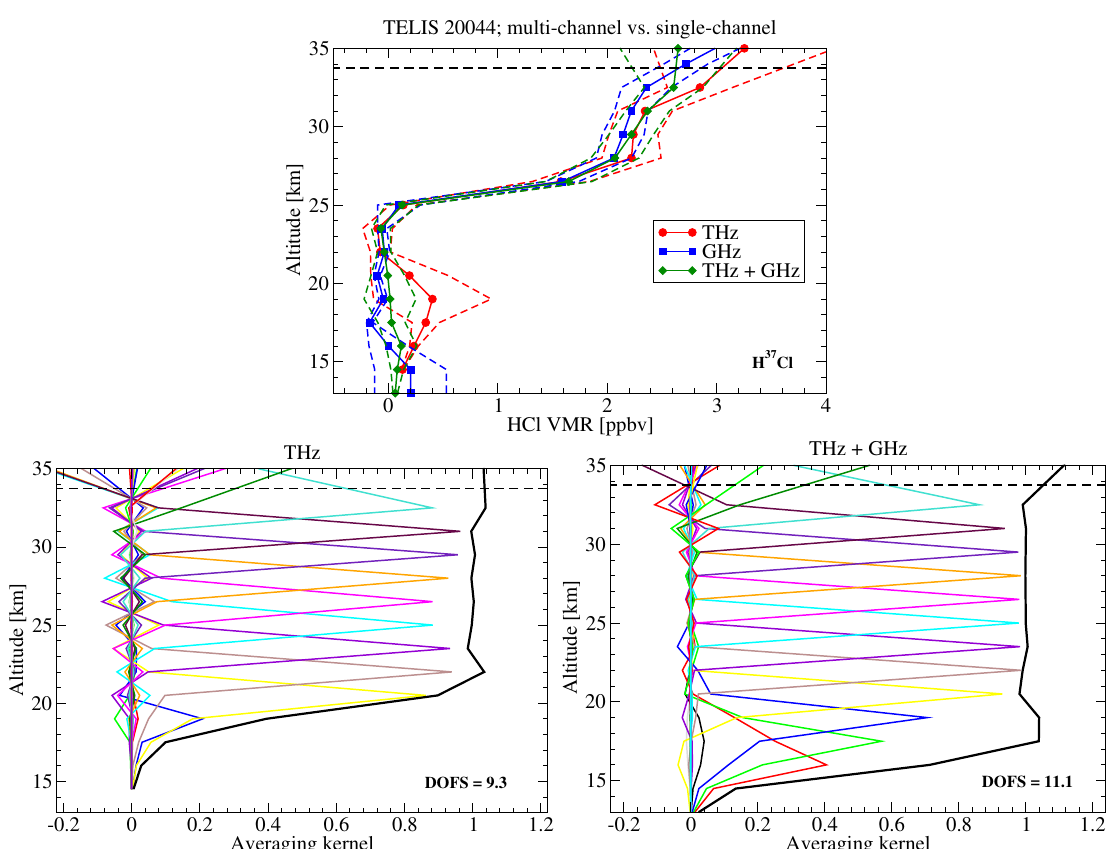
Figure 9. Retrieval result of HCl by using single- and multi-channel data of TELIS. Top panel: intercomparison of the retrieved HCl profile by using single- and multi-channel data. The HCl profile derived from the GHz-channel data is included for reference. Bottom panel: the corresponding averaging kernels and degree of freedom for the signal (DOFS) for the retrievals using single-channel (THz) data and for multi-channel data, respectively.